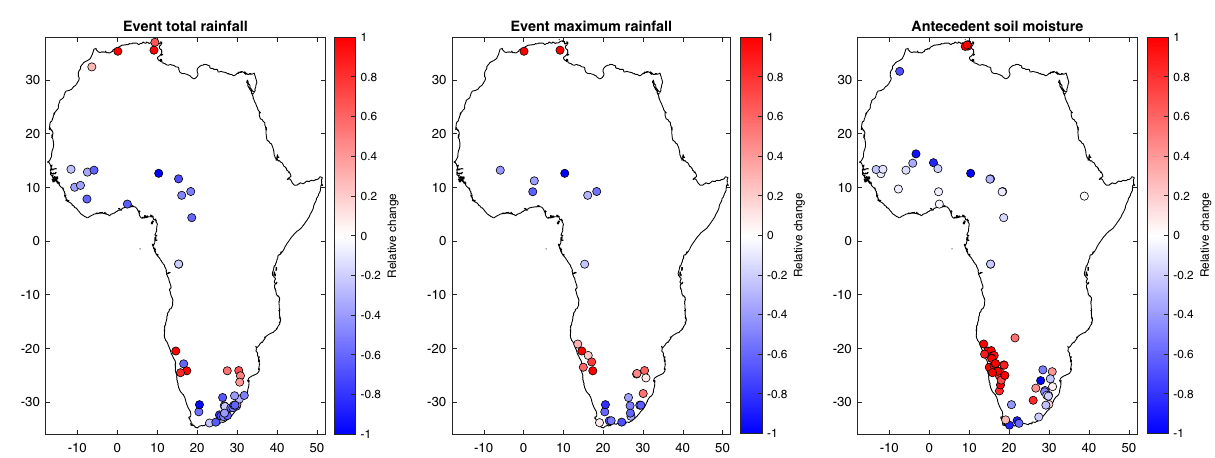
Figure 5. Changes in flood generating processes over time. Red (blue) colors indicate an increase (decrease) in the frequency of occurrence for a given flood trigger in the second period.